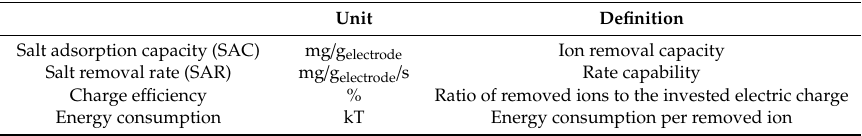
Table 1. Standard analysis metrics in CDI.